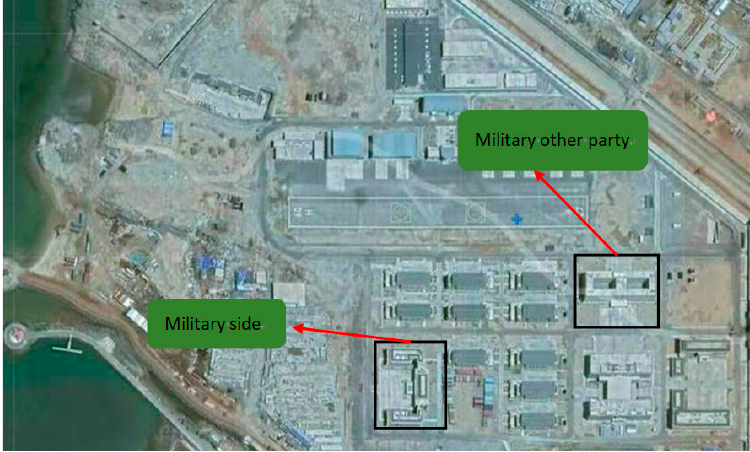
Figure 4. Site selection diagram of military base.